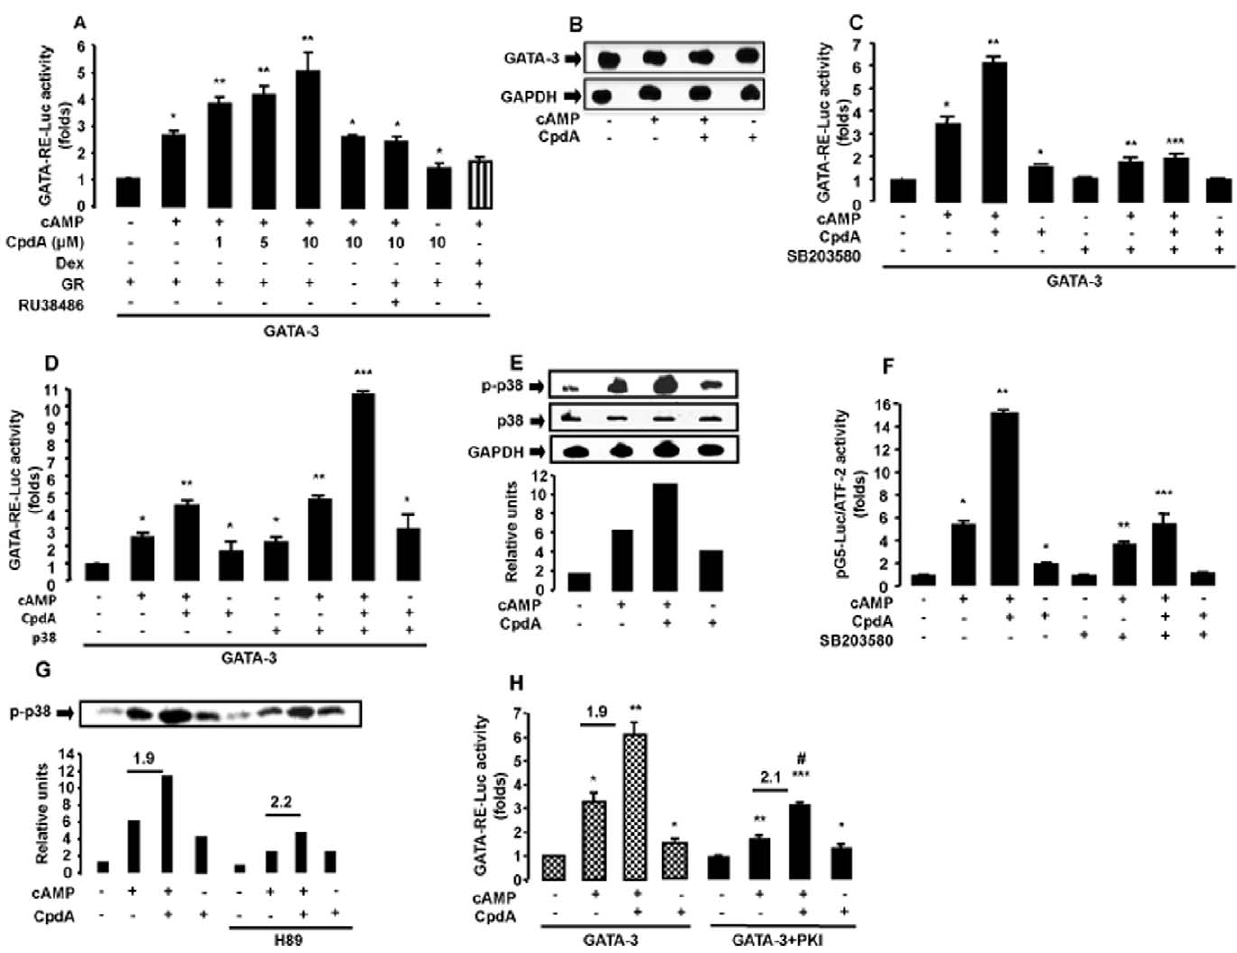
Figure 4. Compound A induces GATA-3 transcriptional activity by signaling through p38 MAPK. A, EL4 cells were transfected with 9 m g of a reporter plasmid, which contains GATA-3 response elements upstream of the luciferase gene (GATA-RE-Luc) and with 9 m g of GATA-3 and GR expression vectors. After 16 h, cells were stimulated for 5 h with Compound A (CpdA, 1, 5 and 10 m M), Dexamethasone (Dex, 10 nM), cAMP (0.3 mM) and with the GR specific antagonist RU38486 (1 m M). n = 6, * p , 0.001 vs. GATA-3 without CpdA and cAMP, ** p , 0.001 vs. GATA-3 with cAMP